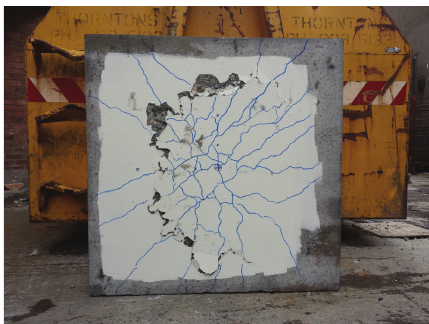
Figure 27: Crack pattern on Soffit of slab S1.